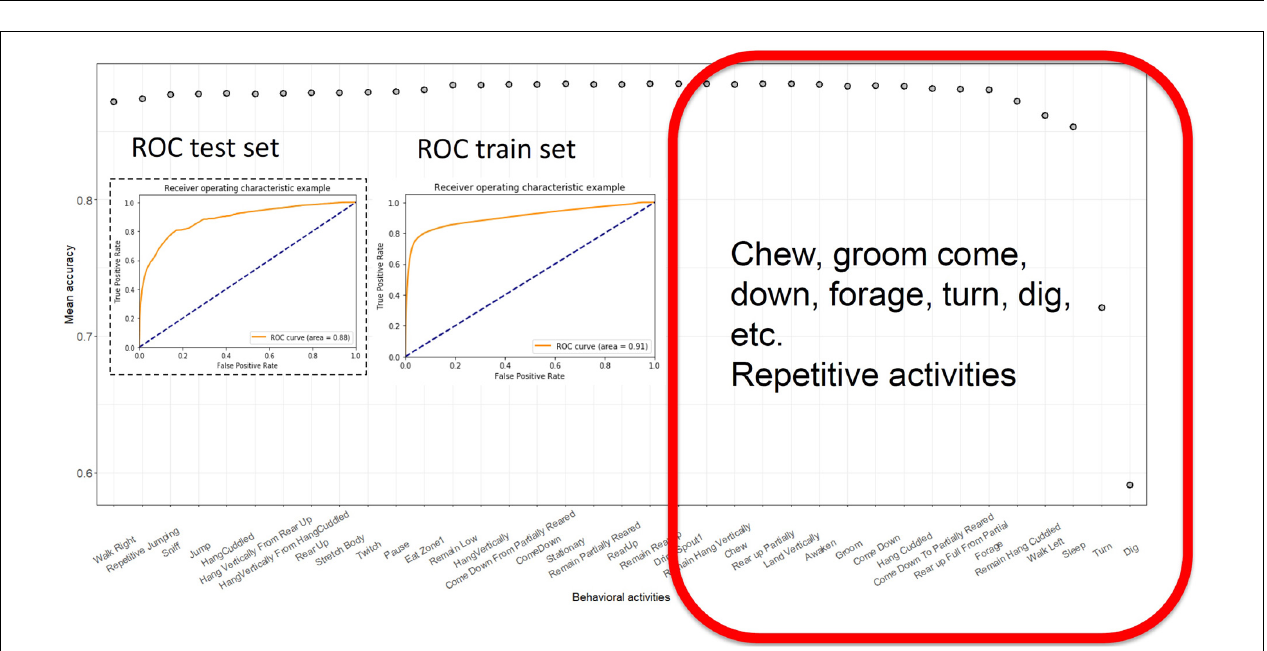
FIGURE 2 | Summary of logistic regression (LG). Inserts show receiver operating characteristic (ROC) (A) curve, precision summary (B) , and graphical representation of the ratio of true positives to false positives (C) . Open circles represent predictions. The majority of predictions are correct; consequently, the circles overlap into apparent lines. Dots above marked bars represent incorrect predictions.